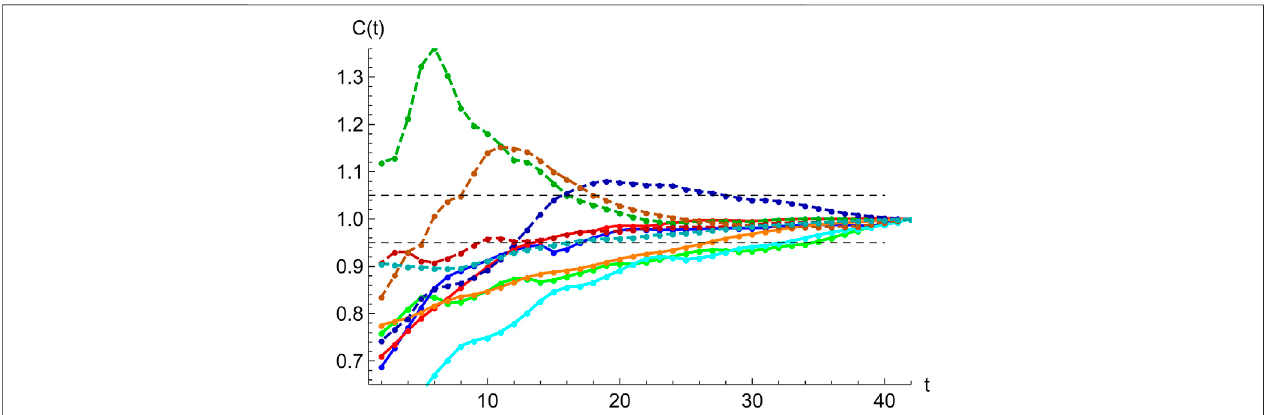
FIGURE7| AccuracyofSHRbest fi ts.Startingatthesecondin fl ectionpoint, t 2 ,fractionalerrorintheevolutionofthepredictedaccumulatednumberofcases C ( t ) for: (1) GBR (green), (1) ESP (blue), (2) ITA (red), (3) GBR (green), (4) FRA (orange), (5) United States (cyan), (6) CHE (dashed darker green), (7) DNK (dashed darker blue), (8)DEU(dasheddarkerred),(9)AUT(dasheddarkerorange)(10)FIN(dasheddarkercyan).Theregion ± 5%isdelimitedbyblackdashedlines.Acommonnormalizacion has been used by making C ( t 2 + 40 ) (cid:2) 1 for all